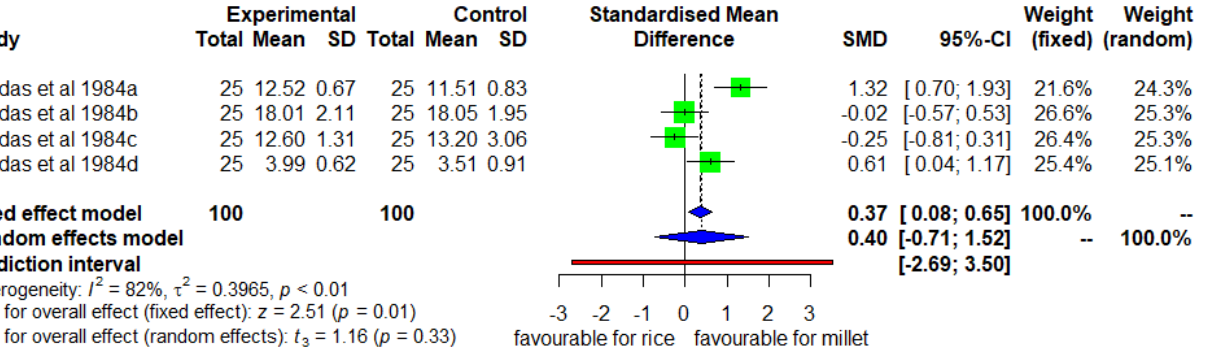
Figure 9. Effect of consuming an enhanced diverse millet-based diet on mean chest circumference change compared to an enhanced diverse rice-based diet.